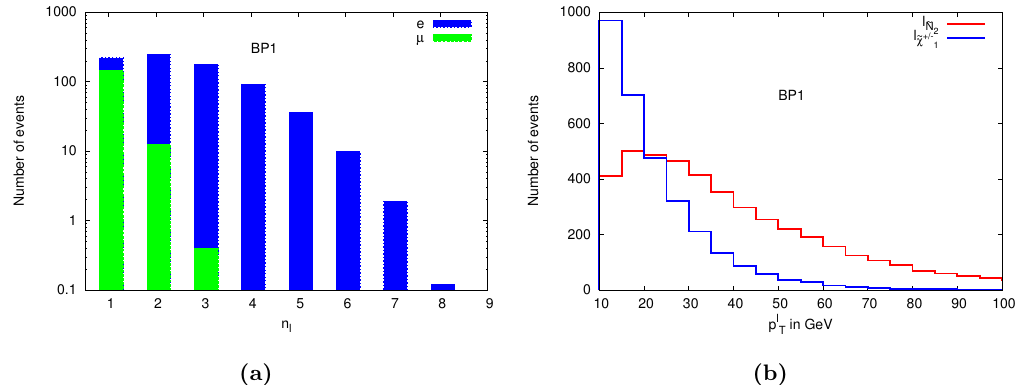
Figure 4. Electron and muon multiplicity distribution (a) and their p T distribution (b) at the LHC with 14 TeV.